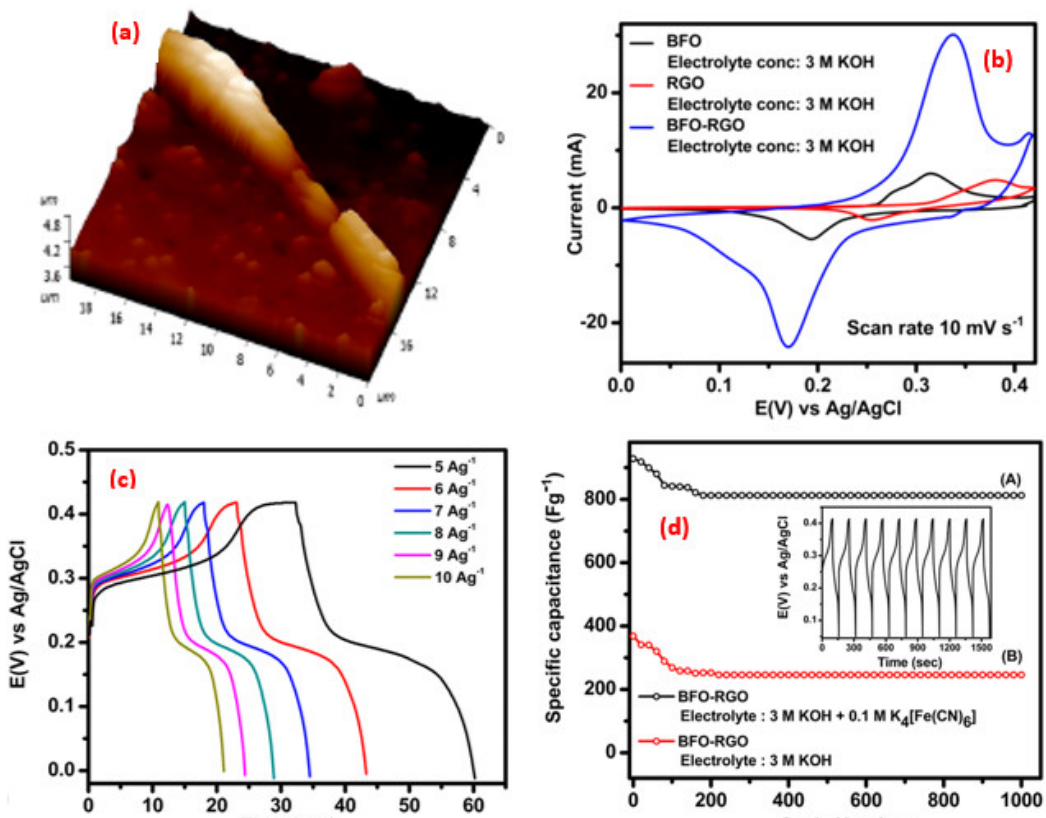
Figure 2. ( a ) Atomic force microscope image of BiFeO 3 nanowire—reduced graphene oxide nanocomposite; ( b ) cyclic voltammetry curves of BiFeO 3 nanowire, RGO, and BFO–RGO electrodes at a scan rate of 10 mV s − 1 in 3 M KOH electrolyte; ( c ) galvanostatic charge − discharge profile of BFO–RGO electrode in 3 M KOH + 0.1 M K 4 [Fe(CN) 6 ] with a changing current density of 5 to 10 A g − 1 ; and ( d ) cyclic stability of the BiFeO 3 nanowire-reduced graphene oxide electrode in ( A ) 3 MKOH + 0.1 M K 4 [Fe(CN) 6 ] and ( B ) 3 M KOH showing the capacitance retention after 1000 cycles using a charge/discharge at a constant current density of 5 A g − 1 . Copyright 2019 by the American Chemical Society